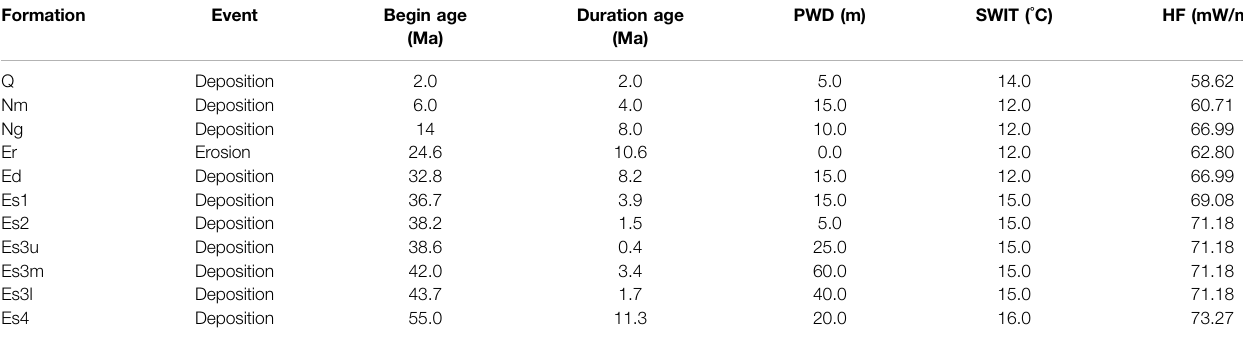
TABLE 1 | Geological framework and boundary condition used in the basin modeling of the Linnan Sag (modi fi ed from Wang (2019)). Formation